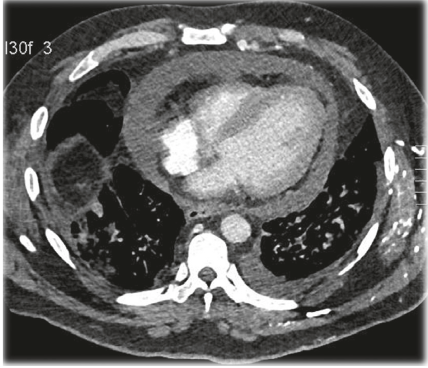
Figure 2: CTA chest with a moderate pericardial effusion.